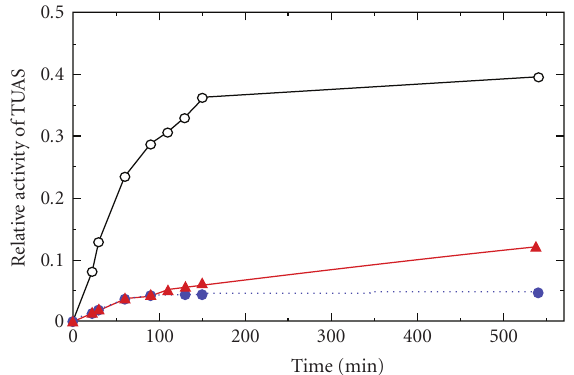
Figure 4: Time course of TUAS activity of M. luteus and the e ff ect of phospholipase C on the activity. Open circle: TUAS activity; Closed circle: TUAS treated with phospholipase C; Triangle: addition of artificial phospholipid vesicles to TUAS reaction mix following phospholipase